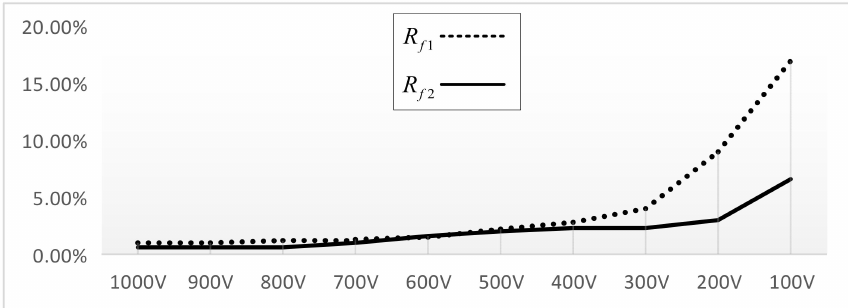
Figure 13. RE% with di ff erent DC